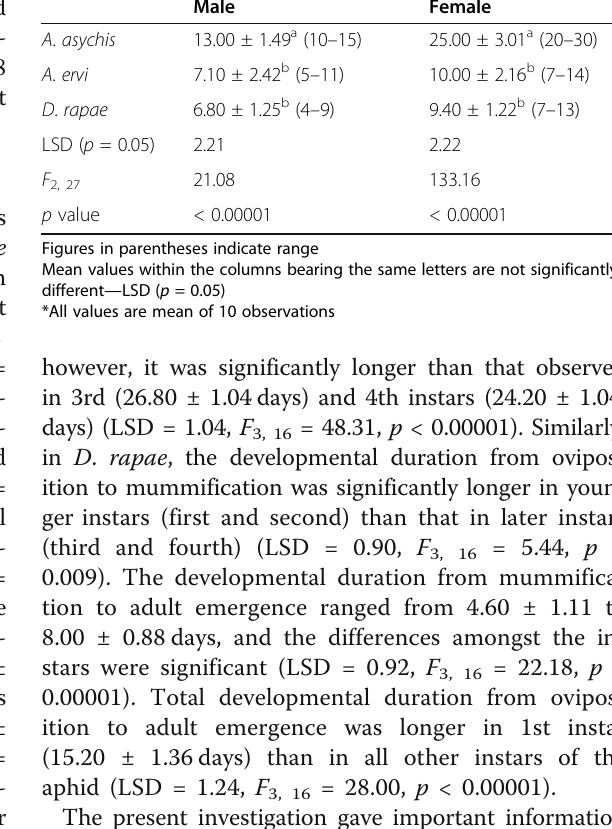
Table 4 Mean longevity (mean ± S.E.) of A . asychis , A . ervi , and